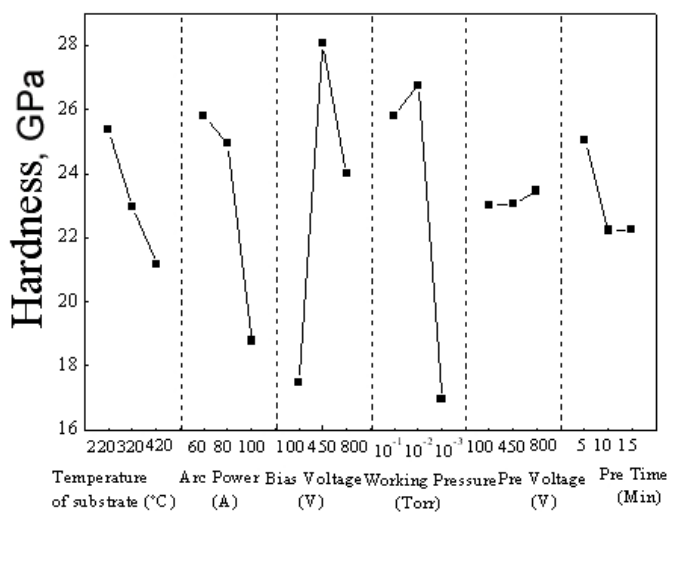
Figure 5. Response graph for the six factors vs.